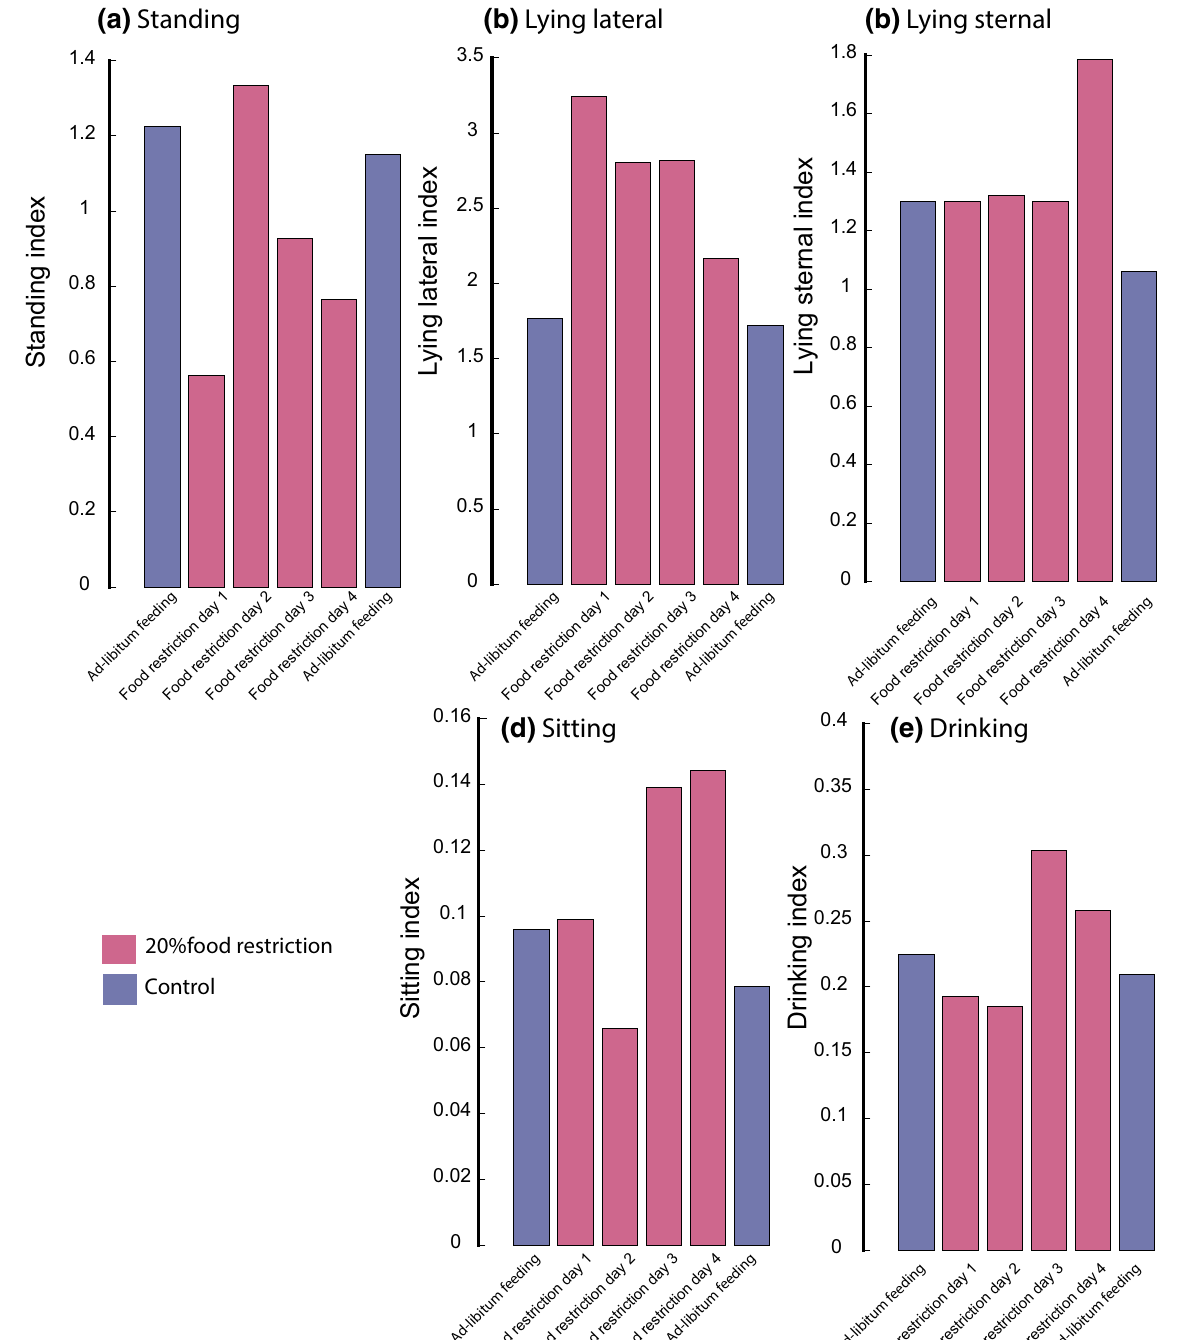
Figure 1. The scored ( a ) standing, ( b ) lateral lying, ( c ) sternal lying, ( d ) sitting and ( e ) drinking indices per day (11:00–15:00) across the study period. The indices were calculated to provide consistent measures across various data frames. Control bars represent indices averaged across 2 days immediately before and after the food restriction period. These metrics were obtained using the developed/validated primary